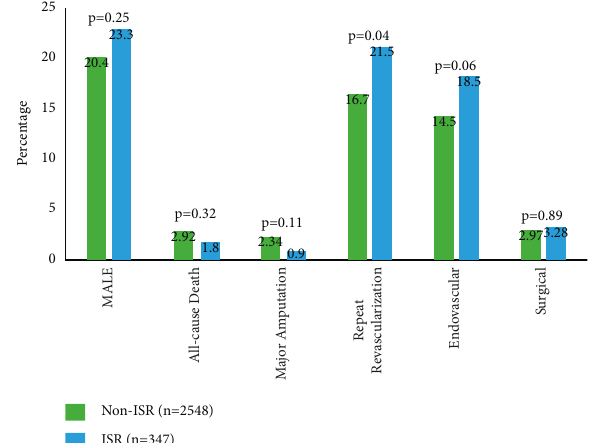
Figure 1: 1-year major adverse limb events (MALE) and repeat revascularization for femoropopliteal (FP) non-in-stent restenosis and in- stent restenosis (ISR) groups.